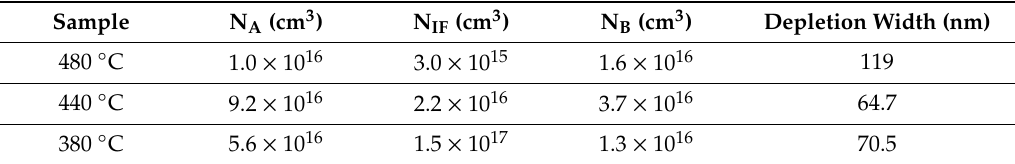
Table 2. Summary of the results derived from the CV and DLCP measurement of CZTSe PV devices. (N A : Free carrier density, N IF : Interface defect density, N B : Bulk defect density).